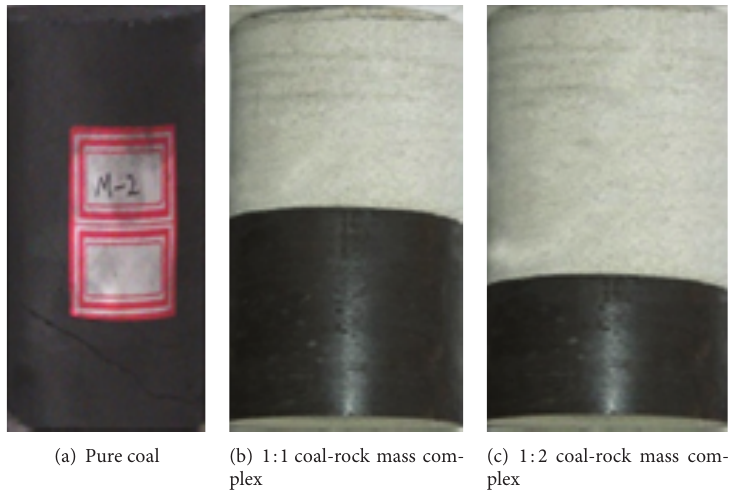
Figure 1: The bursting proneness test samples of coal-rock mass combination.